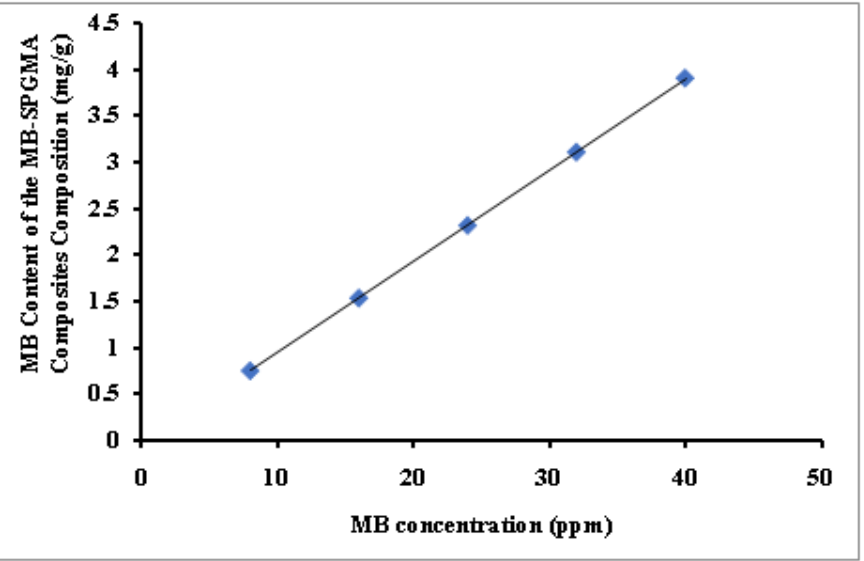
Figure 2. Effect of the MB concentration on the MB content of the MB-SPGMA composites compo- sition.